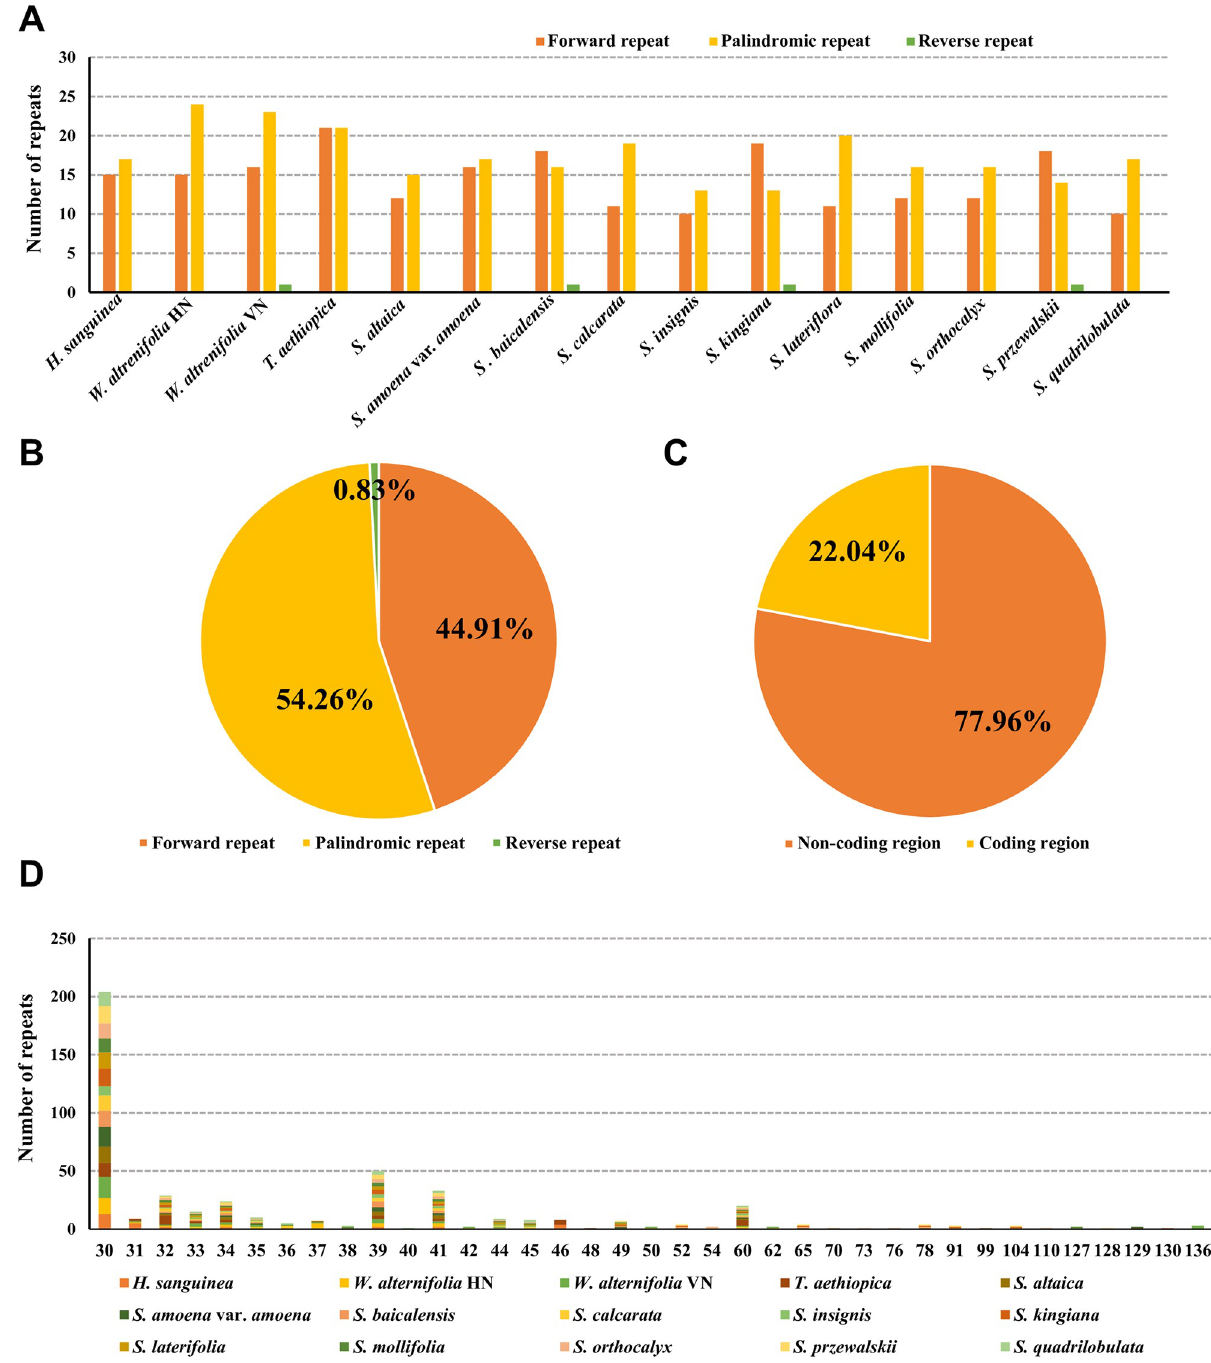
Fig 4. Long repeat sequences in the complete plastomes of 15 taxa of Scutellarioideae. (A) Number of repeat types detected in each plastome; (B) Frequency of each repeat type; (C) Percentages of repeat type loci in the non-coding and coding regions; (D) Frequencies of repeats longer than 30 bp.